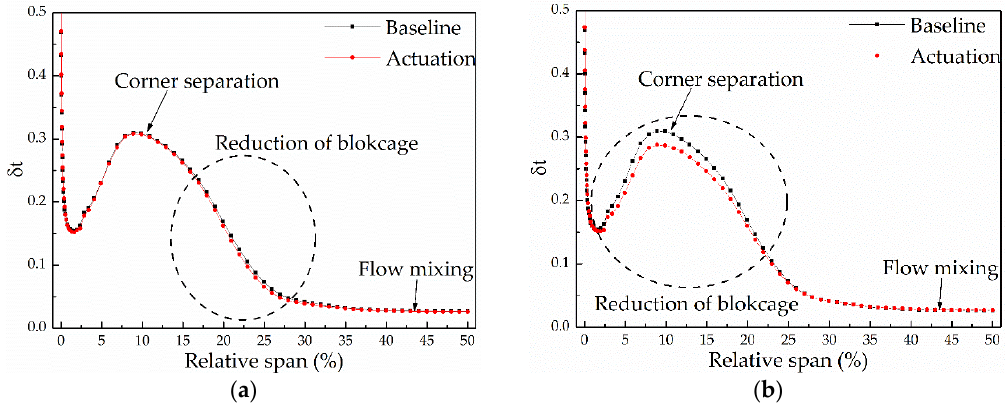
Figure 12. Influences of plasma actuations on the pitch-averaged blockage coefficients of the high-speed compressor cascade. ( a ) Suction surface plasma actuation; ( b ) Endwall plasma actuation.